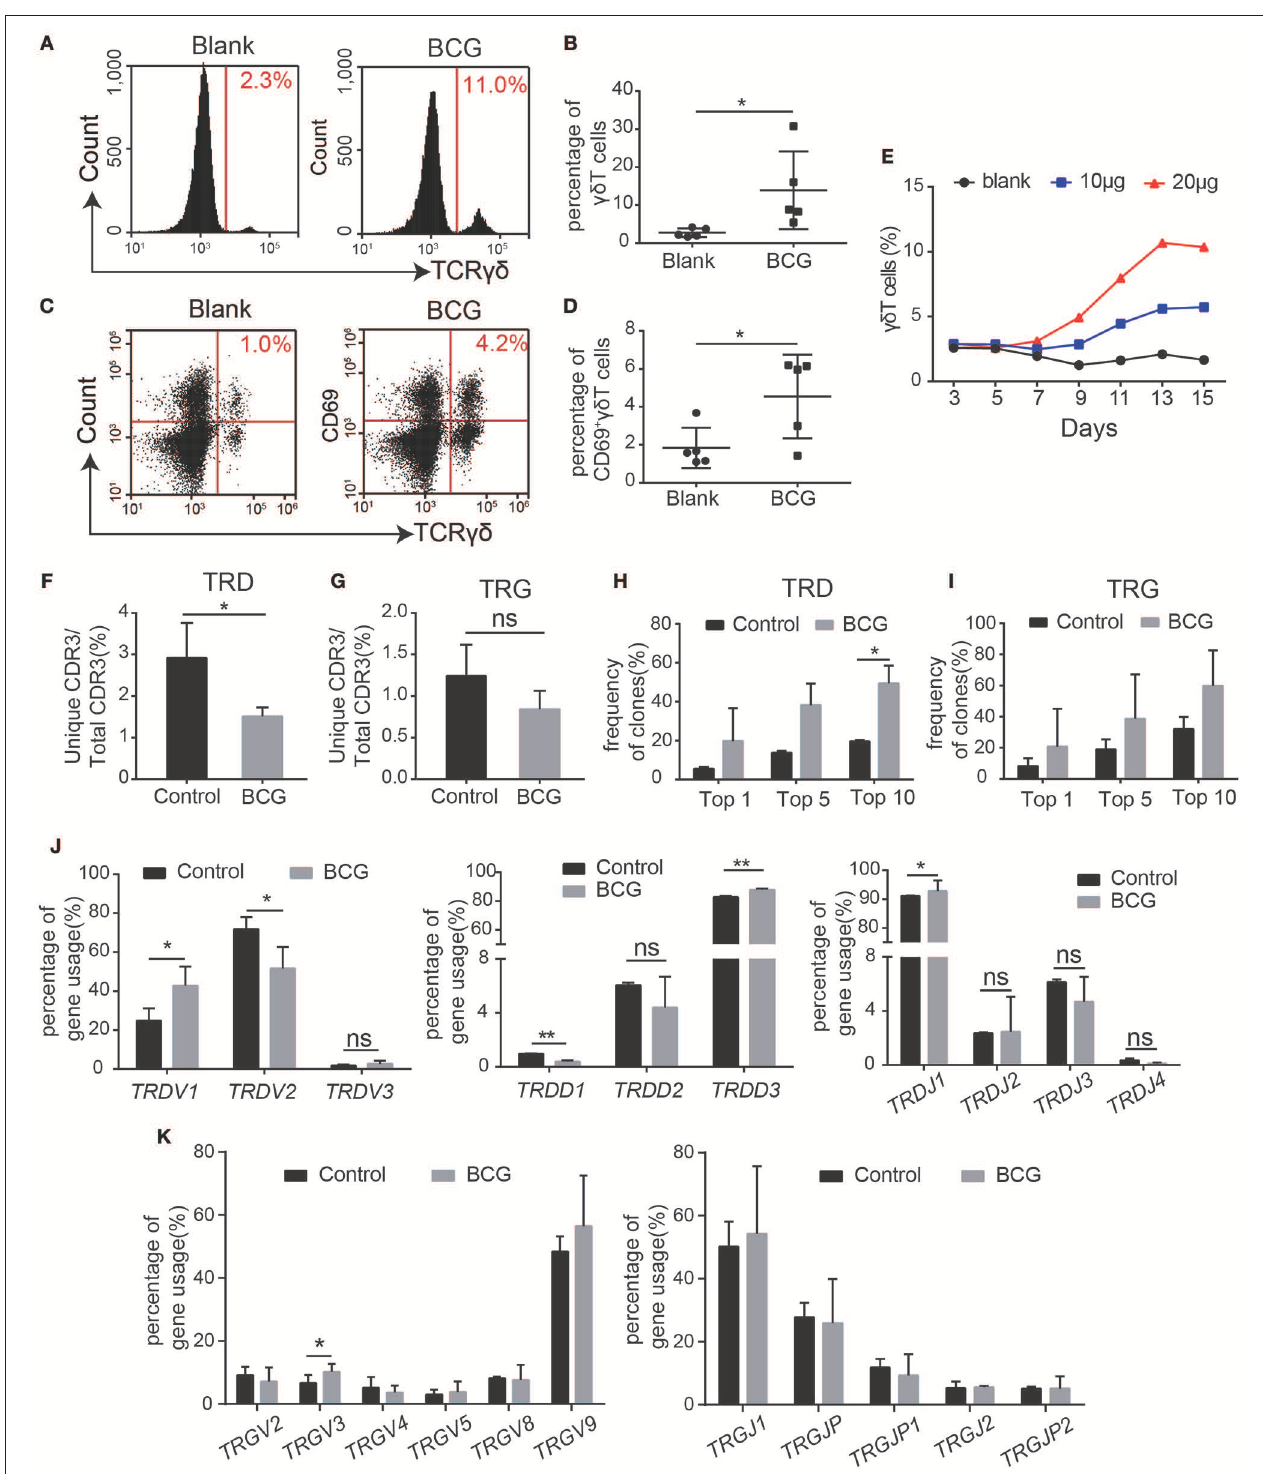
FIGURE 3 | BCG treatment recapitulated the characteristics of the γδ T cell immune repertoire in TB patients. (A–E) Flow cytometry analysis of the proportion of BCG-stimulated γδ T cells and CD69 + γδ T cells (A,C) . Quantification of the proportion of γδ T cells (B) and CD69 + γδ T cells (D) . (E) Average proliferation curve of γδ T cells stimulated by BCG. (F,G) Quantification of the ratios of unique CDR3/total CDR3 of the δ (F) and γ (G) chains in the CDR3 region. (H,I) Frequencies of the top 1, 5, and 10 CDR3 sequences of the δ (H) and γ (I) chains in the CDR3 region. (J) The germline gene usage of T-cell receptor δ -chain (TRD) V fragments ( TRDV1 ,